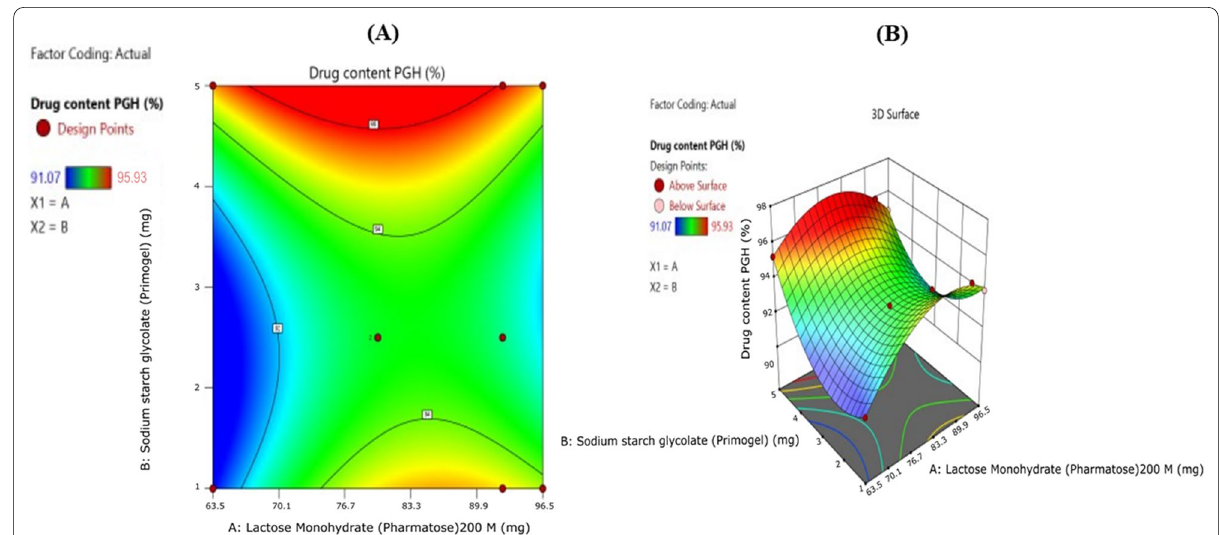
Fig. 4 A Contour plot and B Response surface plot for dependent variables of PGH-IR pellets with drug content as a